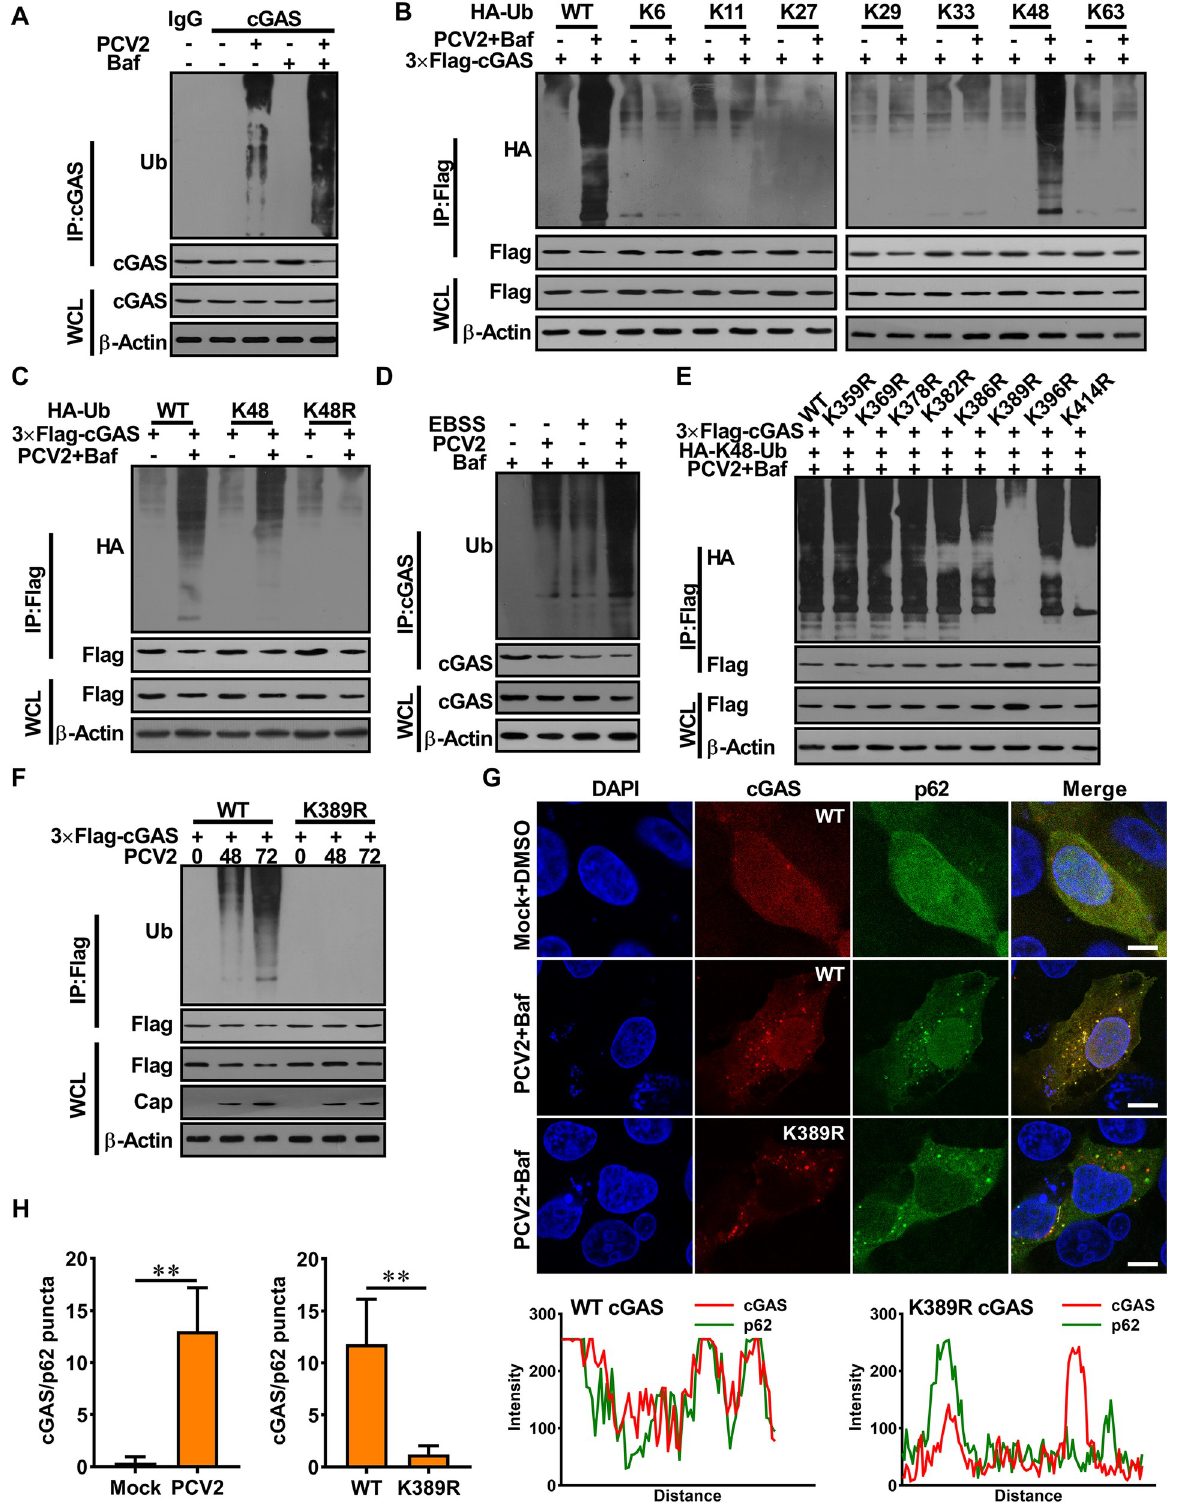
Fig 3. PCV2 infection enhances the K48-linked poly-ubiquitination of porcine cGAS at K389 and facilitates the interaction of cGAS with p62 for autophagic degradation. (A) PCV2 infection enhanced the ubiquitination of porcine cGAS. PK-15 cells were infected with